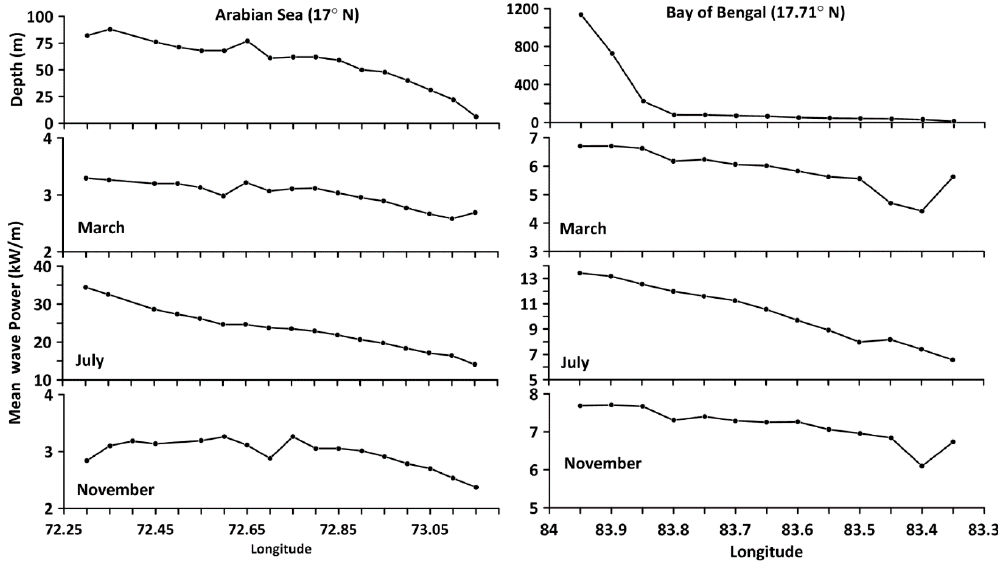
Figure 13. Variation in wave power from deep water to shallow water. Left panel is for location in the Arabian Sea along 17° N and the right panel is for the location in Bay of Bengal along 17.71° N. Top panel is water depth and the other three are for March, July, and November 2015.